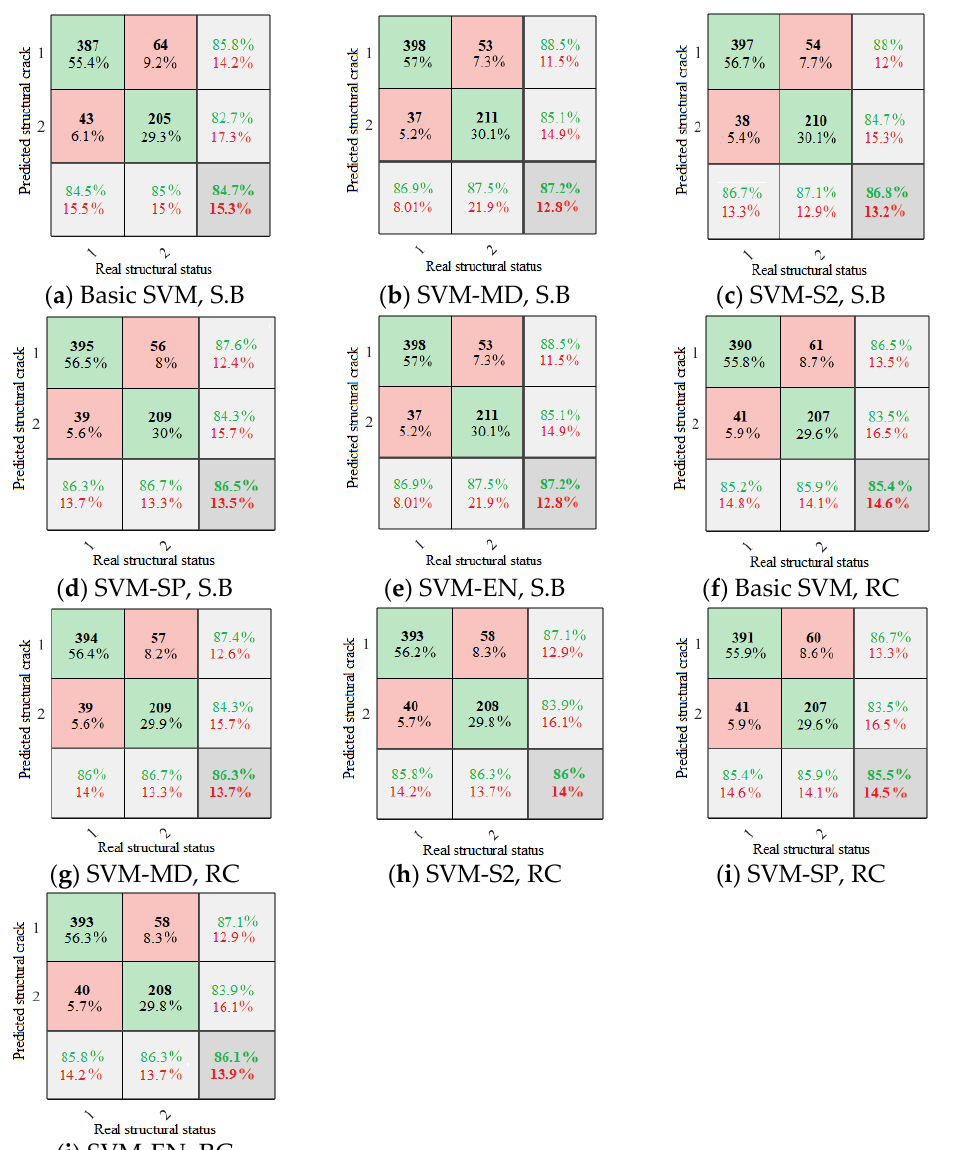
Figure 8. Confusion matrix of enhanced SVM models for S.B and RC beams. The rows correspond to the true class, while the columns correspond to the predicted class. Diagonal and off-diagonal cells correspond to correctly and incorrectly classified observations, respectively.